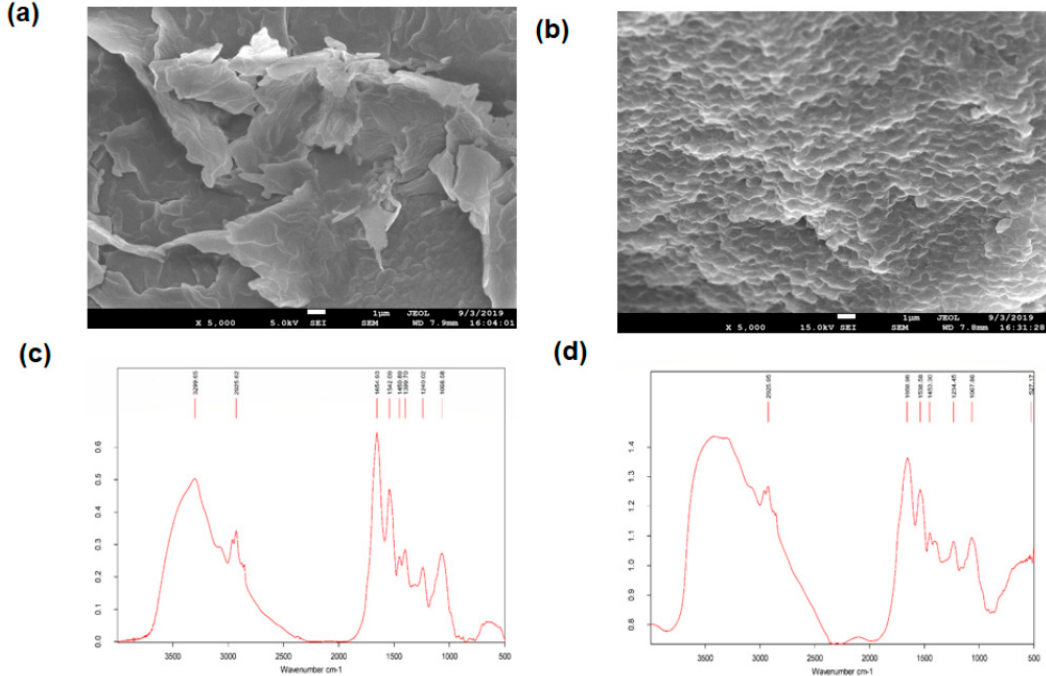
Figure 4. Scanning Electron Microscopy (SEM) and Fourier Transform Infrared Spectrometric (FTIR) analysis of biomass of Klebsiella sp. (SH-1). ( a ) SEM of controlled biomass and ( b ) chromium treated biomass. ( c ) FTIR of controlled biomass and ( d ) chromium treated biomass. Table 3. Elemental content in bacterial biomass after treated with 100 mg/L Cr(VI).